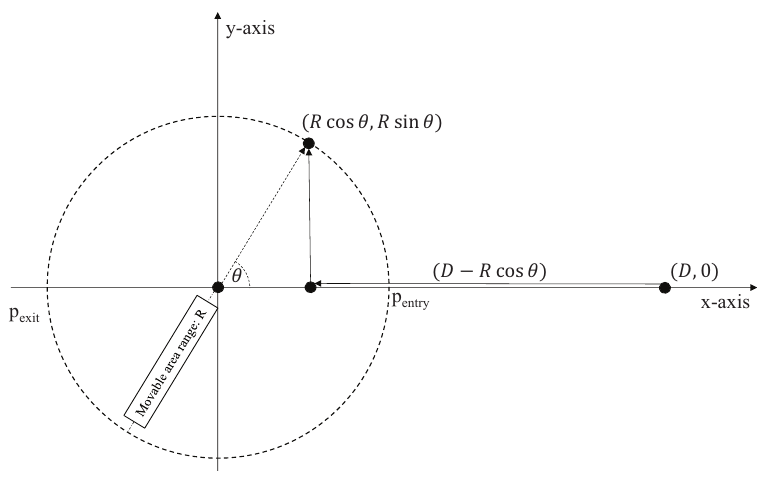
Figure 2. Longest distance in the movable